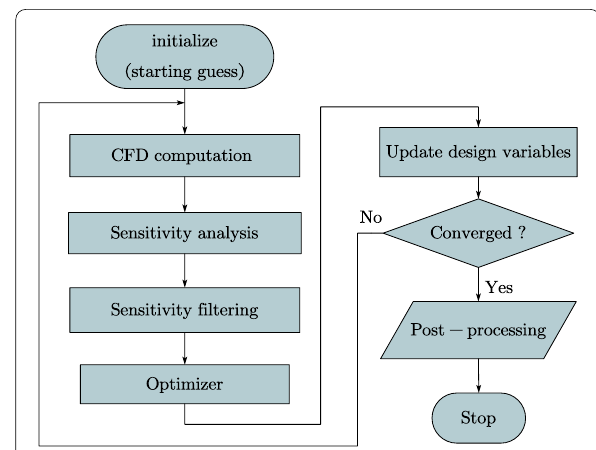
Figure 8 Flow-chart of computations for topology optimization